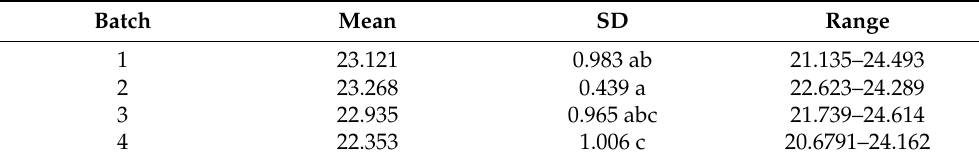
Figure 2. Change in specific density of walleye pollock eggs over time; n = 20 at each measurement. The horizontal line shows the density of the coastal Oyashio water ( σ t 26.4). Table 3. Specific density (sigma-t) of newly hatched walleye pollock larvae, n = 20. (Tukey-HSD test, p < 0.05).